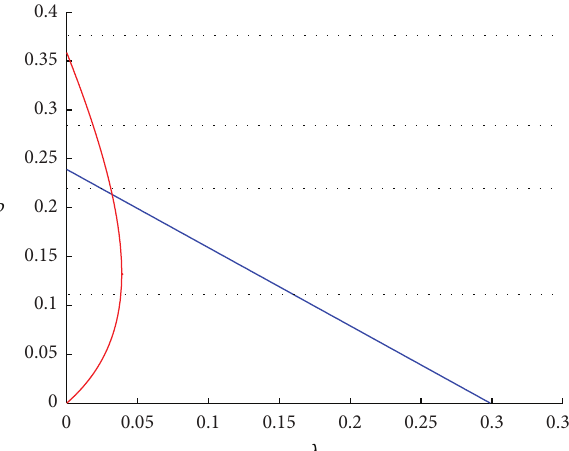
Figure 3: Graph of 𝐸 𝑛 (𝜆,𝑝)𝐹 𝑛 (𝜆,𝑝) = 0 . Here 𝑑 = 0.5 , 𝛼 = 0.4 , 𝛽 = 1.2 , 𝑙 = 30 , 𝑢 ∗ = 0.1892 , V ∗ = 0.227 , and 𝜆 𝐻 horizontal lines are 𝑝 = 𝑛 2 /𝑙 2 , where 𝑛 = 0, 1,2, . ..